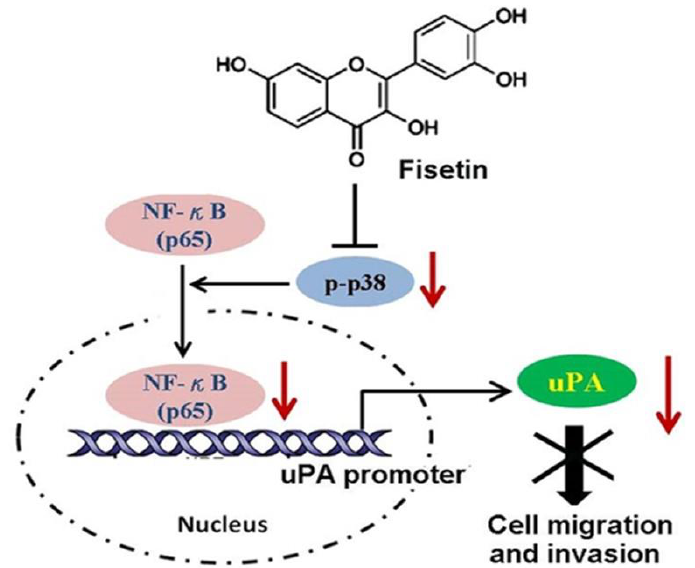
Figure 3. Fisetin inhibits the migration and invasion of cancer cells. Fisetin inhibits the phosphorylation of p38 MAPK, and impairs translocation of NF- κ B to the nucleus. The decreased NF- κ B in the nucleus reduces its binding to the promoter of the uPA gene, and results in repressing the expression and activity of uPA, thereby disrupting the migratory and invasive ability of cancer cells. Adapted from [57]. Copyright: © 2013.